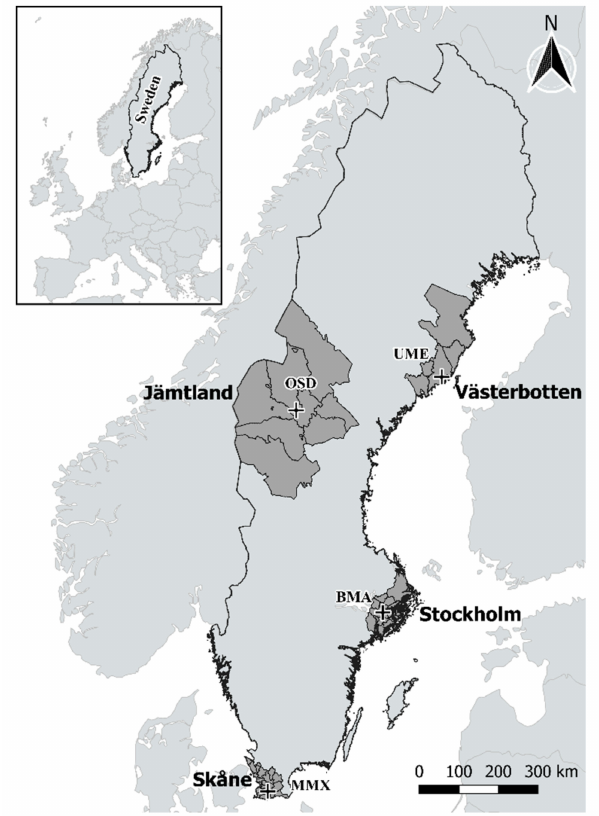
Figure1. MapofSwedenwithstudylocations. Thefourstudyregionsareindarkgray. Locationsofmain weather stations in each study area are represented by black crosses (Malmö—MMX, Bromma—BMA, Östersund—OSD, and